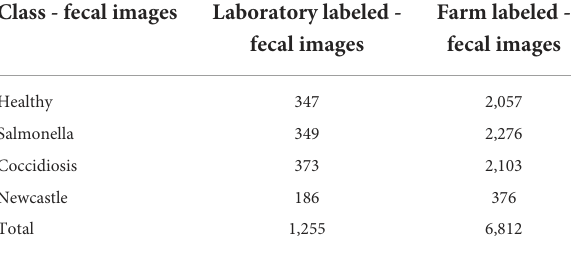
TABLE 1 Dataset distribution of poultry fecal images for three diseased classes and one healthy class. Class - fecal images Laboratory labeled - Farm labeled - fecal images fecal